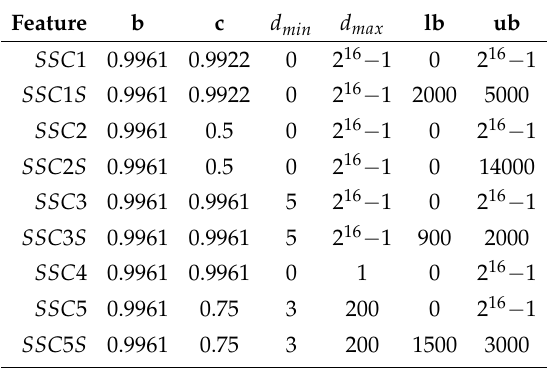
Table 3. Parameters of SSC